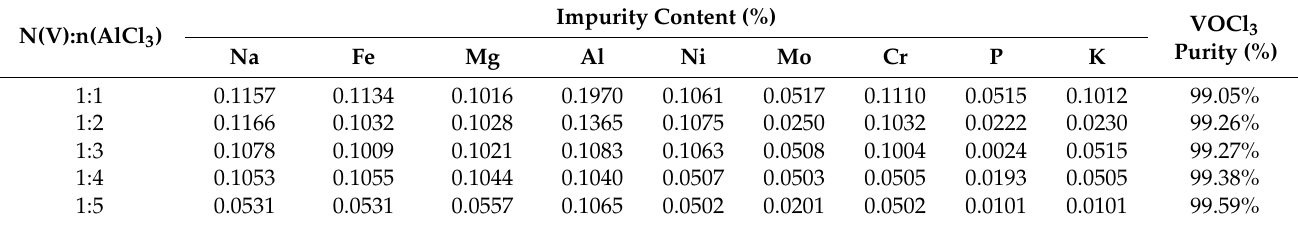
boiling point of NaAlCl 4 is much higher than the chlorination reaction temperature. Therefore, 170 °C was chosen as the optimal temperature.